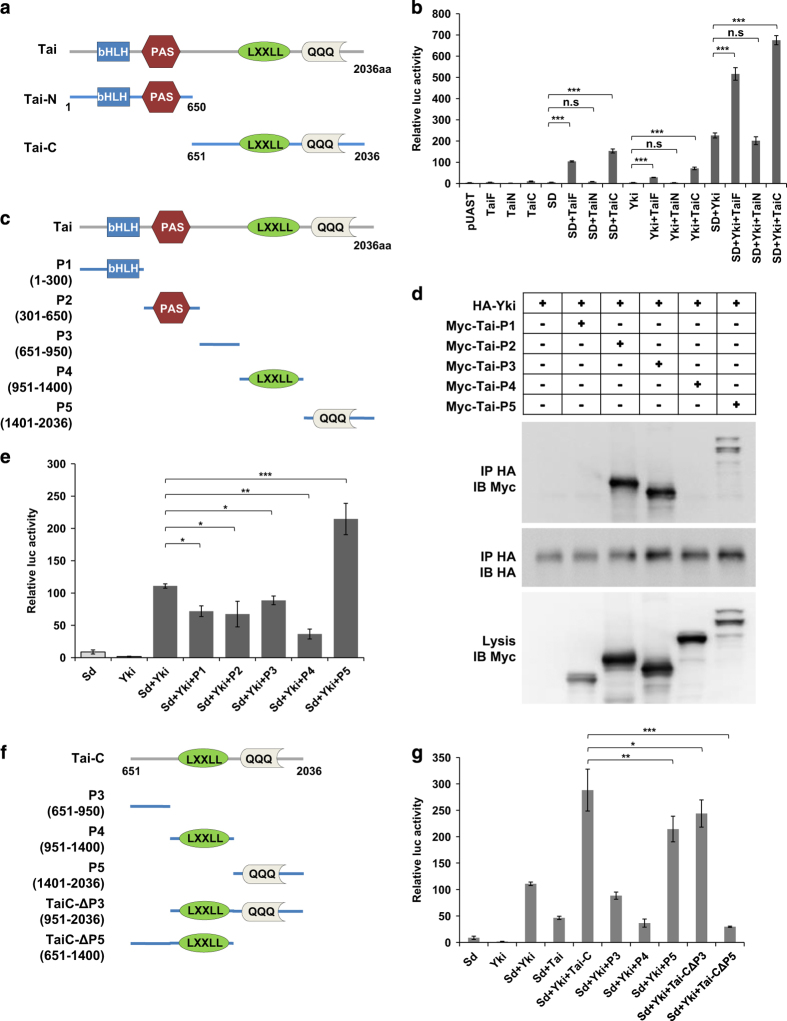
Characterization of different domains of Tai. (a) Schematic diagram of the N- and C- truncations of Tai protein. (b) TaiC sufficiently enhances the activity of Sd-Yki to trigger 3xSd2-luc reporter gene whereas TaiN does not. S2 cells were transfected with indicated constructs and luciferase reporter gene, followed by dual luciferase assay. The data were quantified using an unpaired t-test. The results represented the mean± s.e.m. ***P<0.001, **P<0.01, n.s., no significant difference (n=3). Note that the activity of TaiC is even higher than that of Tai full length. (c) Schematic diagram of the different domains of Tai protein. (d) CoIP of Myc-tagged TaiP2, TaiP3, Tai-P5 and Flag-Yki. S2 cells were transfected with indicated constructs, followed by immunoprecipitation and western blot analysis with indicated antibodies. (e) Tai-P5 acts synergistically with Sd-Yki to activate 3xSd2-luc reporter gene. Tai acts synergistically with Sd-Yki to activate 3xSd2-luc reporter gene. S2 cells were transfected with indicated constructs and luciferase reporter gene, followed by dual luciferase assay. The data were quantified using an unpaired t-test. The results represented the mean± s.e.m. ***P<0.001, **P<0.01, *P<0.1, n.s., no significant difference (n=3). (f) Schematic diagram of the different variants of Tai protein C-terminus. (g) TaiC-ΔP3 enhances the transcriptional activity of Sd-Yki while TaiC-ΔP5 does not. The data were quantified using an unpaired t-test. The results represented the mean±s.e.m. ***P<0.001 (n=3), ***P<0.001, **P<0.01, *P<0.1, n.s., no significant difference (n=3).